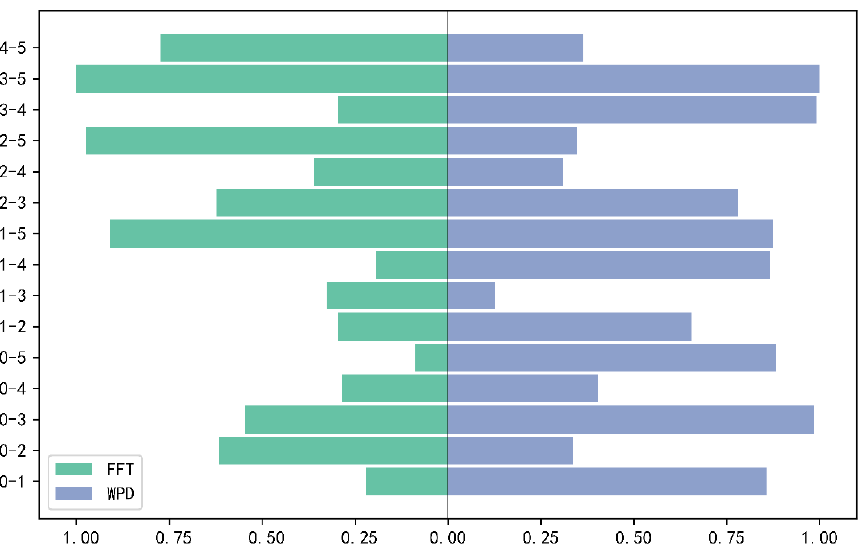
Figure 13. Normalized Wasserstein distance taper figure for two processing methods.